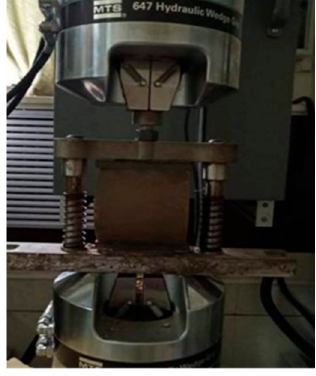
Figure 1. The setup of specimen.